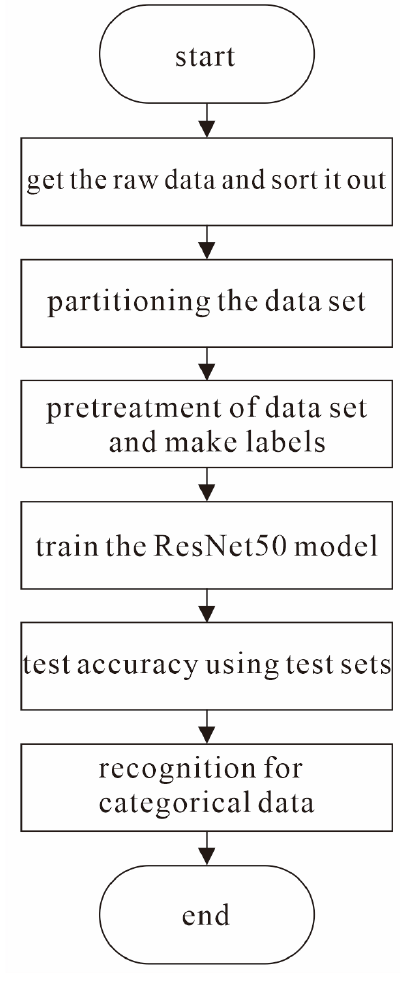
Figure 6. Flow chart.